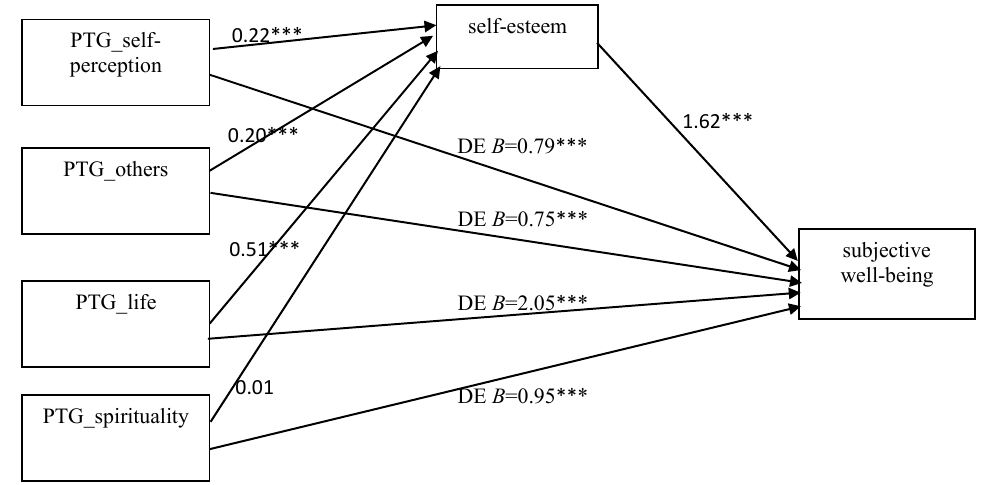
Figure 1. Parallel Mediation Model of Dimensions of PTG on Subjective Well-being Using Self-esteem as a Mediator. Note. Unstandardized coefficients are presented. *** p < 0.001.